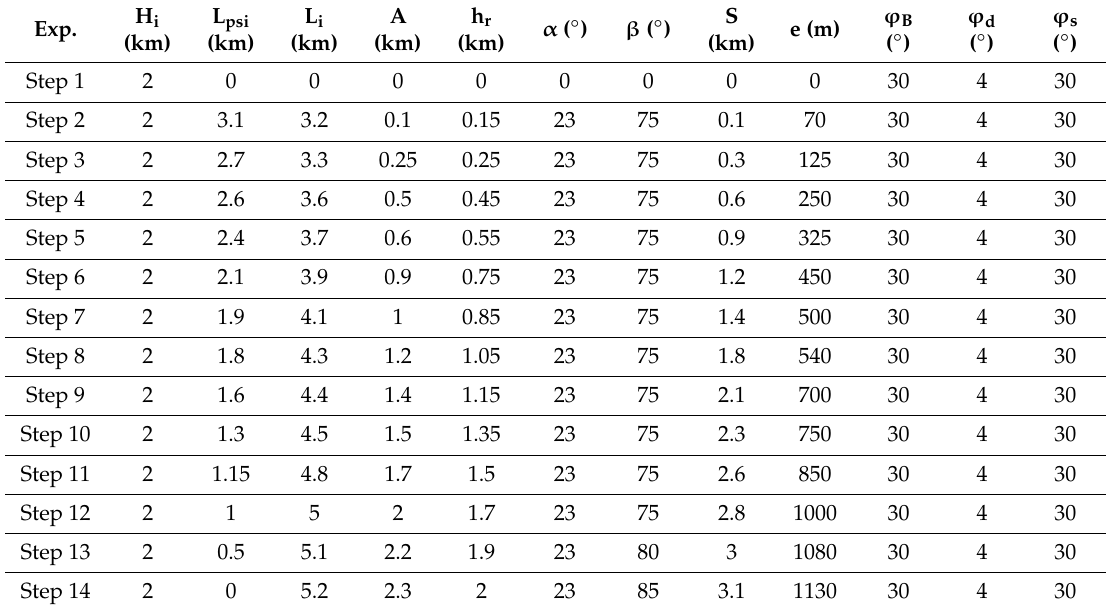
Table 1. Parameter table for each step of the fold evolution (See parameter details in Figure 2’s caption).